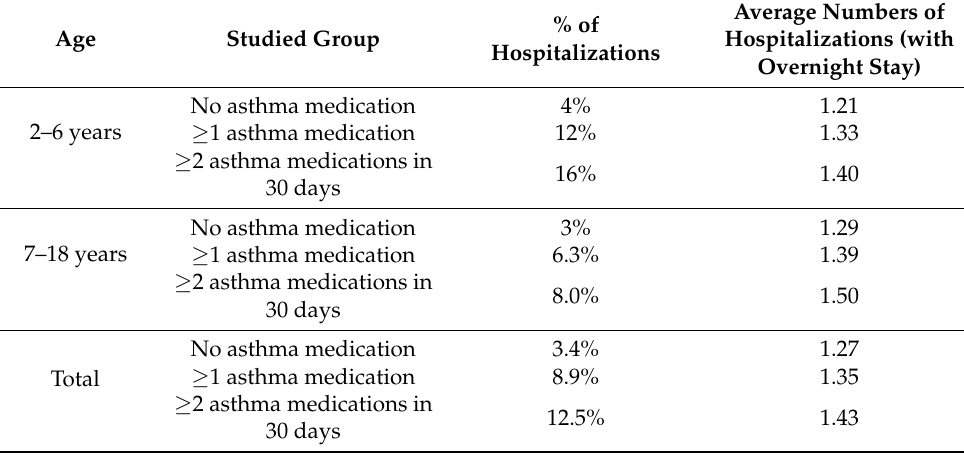
Table 5. Hospitalizations in children according to asthma medications and